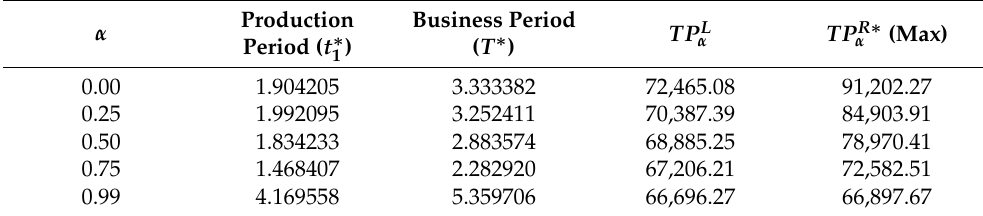
Table 15. Optimum results of Example 5 for maximizing TP R